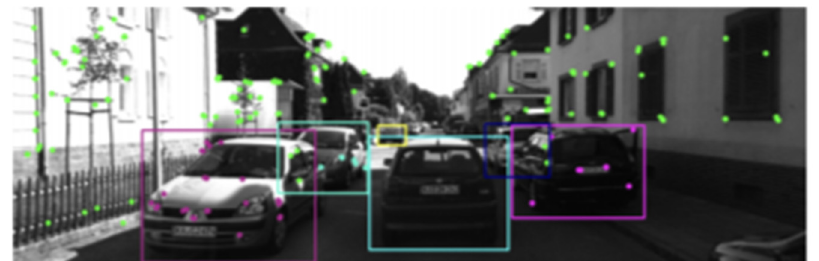
Figure 1. Association of objects in dynamic and occluded scenarios KITTI 07 [44]. Green points are non-objective points, points of other colors are associated with objects of the same color. The front blue moving car is not added as a SLAM landmark since no feature point is associated with it since the car is in motion. Points in the feature overlap region are not associated with any feature due to ambiguity (belonging to two features).